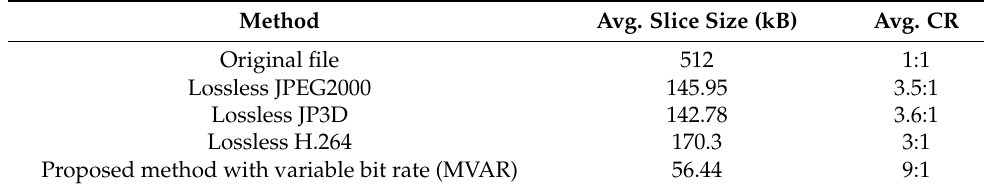
Table 5. Comparative performance evaluation of the four methods for image size reduction evaluation in terms of slice size and compression ratio